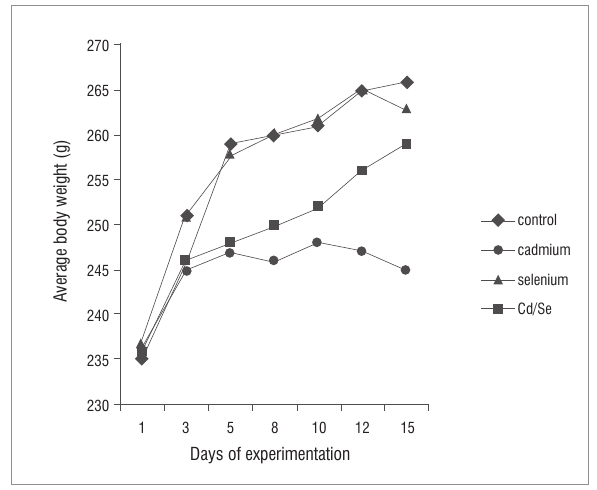
Figure 1: Mean body weight (g) in male rats ( n =5) receiving cadmium (1.67 mg/kg cadmium chloride in saline), selenium (0.23 mg/ kg sodium selenite solution), cadmium and selenium (Cd/Se; 1.67 mg/kg cadmium chloride in saline and 0.23 mg/kg sodium selenite solution) or saline (control) daily (IP) for 15